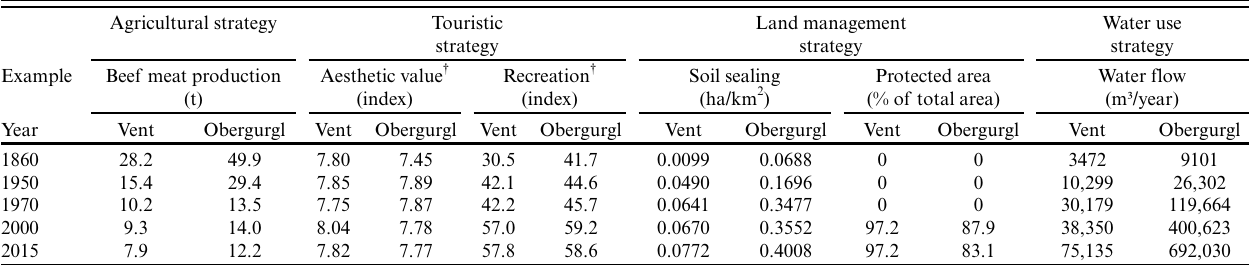
Table 4 . Livelihood outcome presented as ecosystem services (ES) flows.